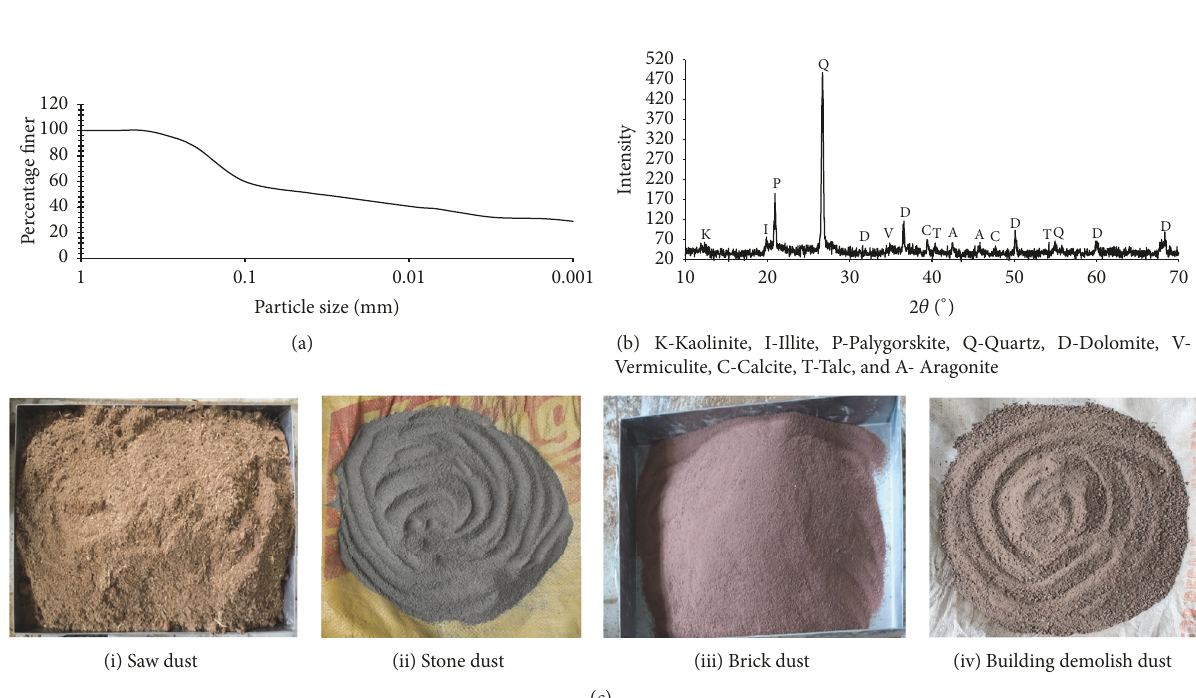
Figure 2: (a) Particle size distribution of soil; (b) XRD diagram of soil used in the present study; (c) Waste dust used to enhance soil